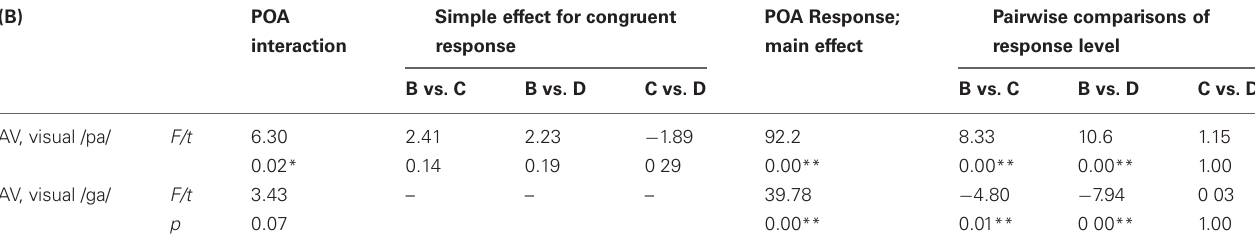
Table 2 | Results for the POA analyses of the multimodal stimuli.